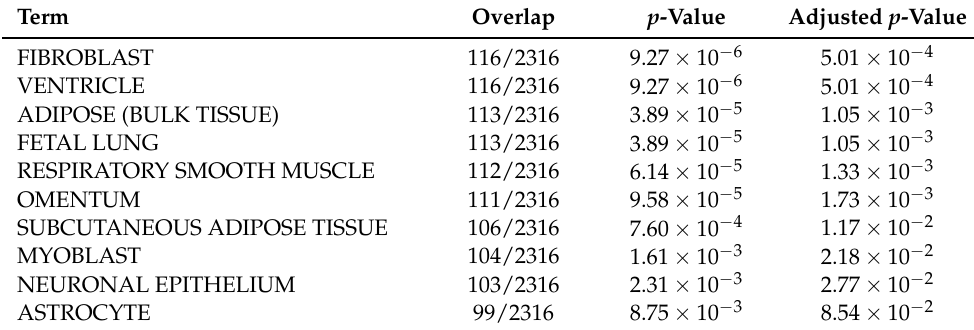
Table 11. The top 10 enriched terms in “ARCHS4 Tissues” using Enrichr. Overlap is the number of common genes between the genes uploaded and the genes in the category divided by the number of genes in the category. Probes, whose associated genes were uploaded to Enrichr, were identified using linear